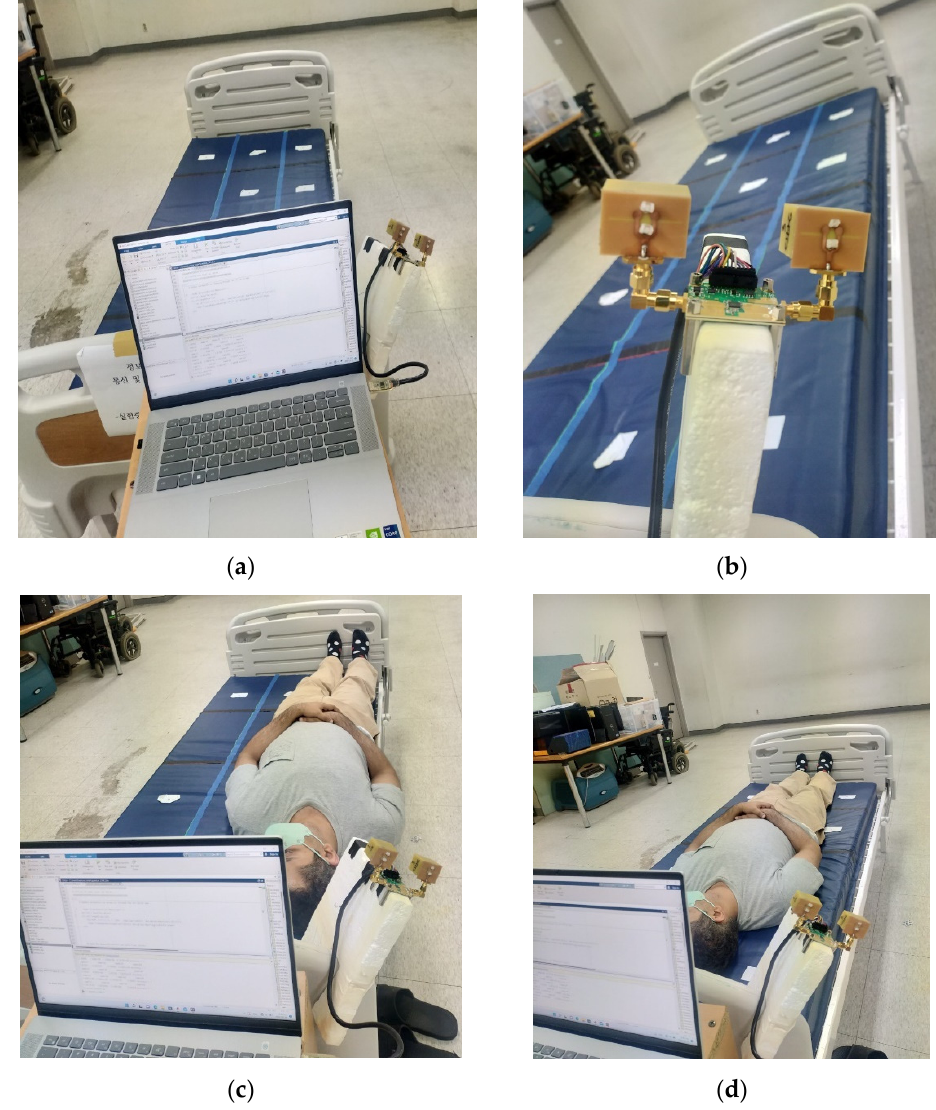
Figure 6. Experimental setup and sleep positions and states: ( a ) Arrangement setup with antenna, Rf cables, PC, with empty bed state; ( b ) UWB radar module with a pair of antennas; ( c ) Right side of the bed; ( d ) Middle of the bed.